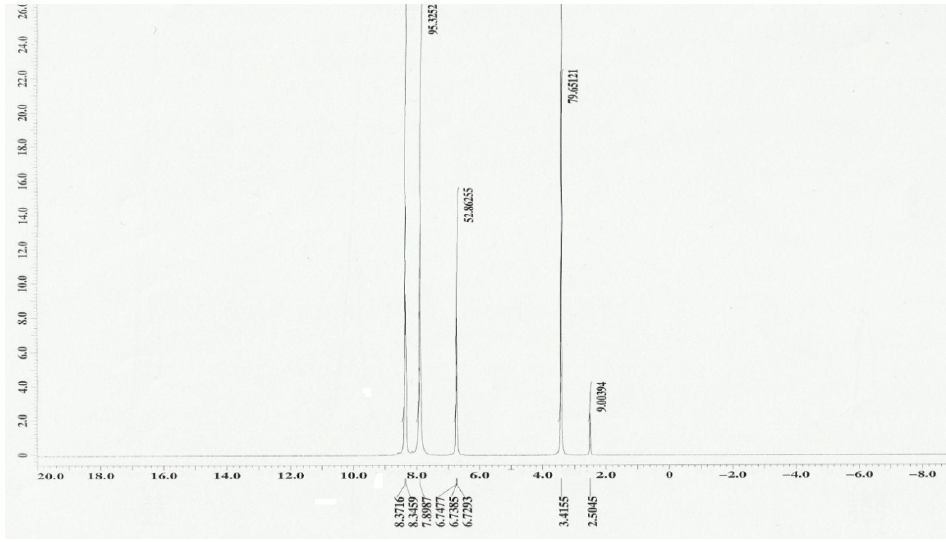
Figure 3 . Experimental 1 H-NMR of ANP.